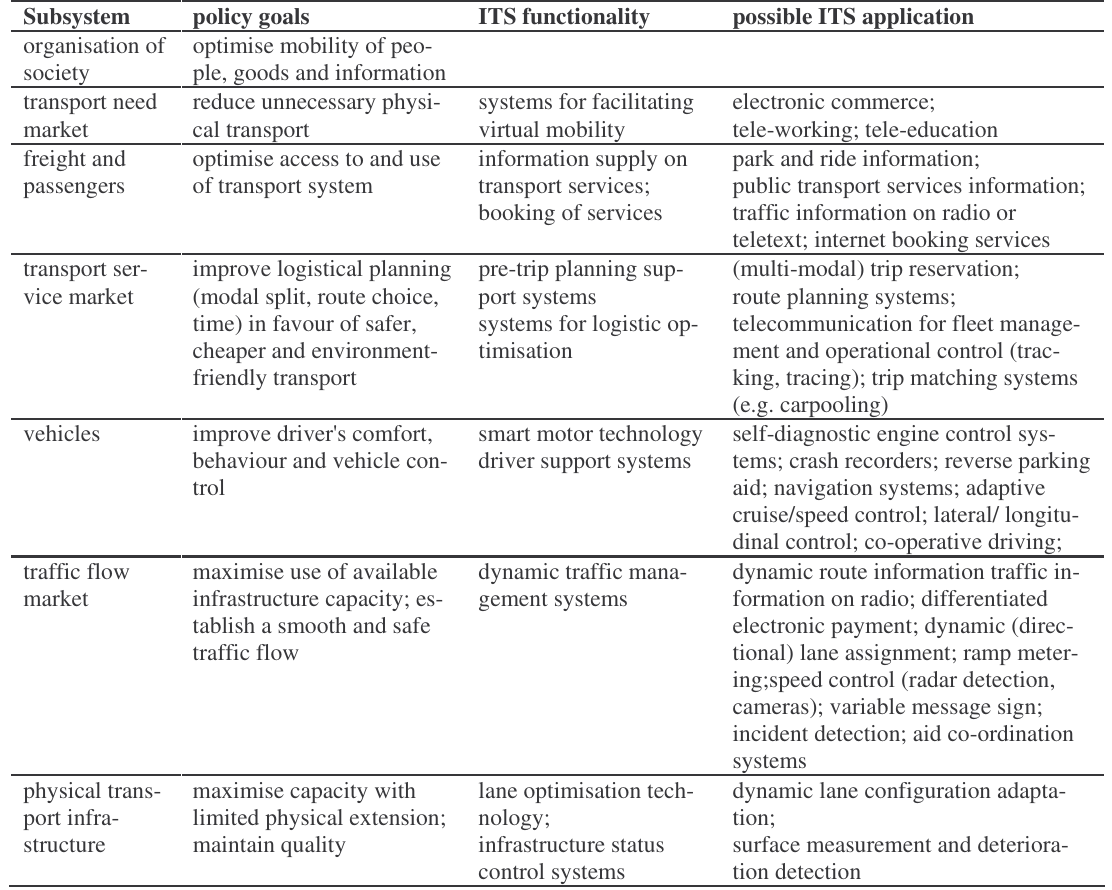
Table 1. Indicative relationship between transportation subsystems, policy goals and ITS